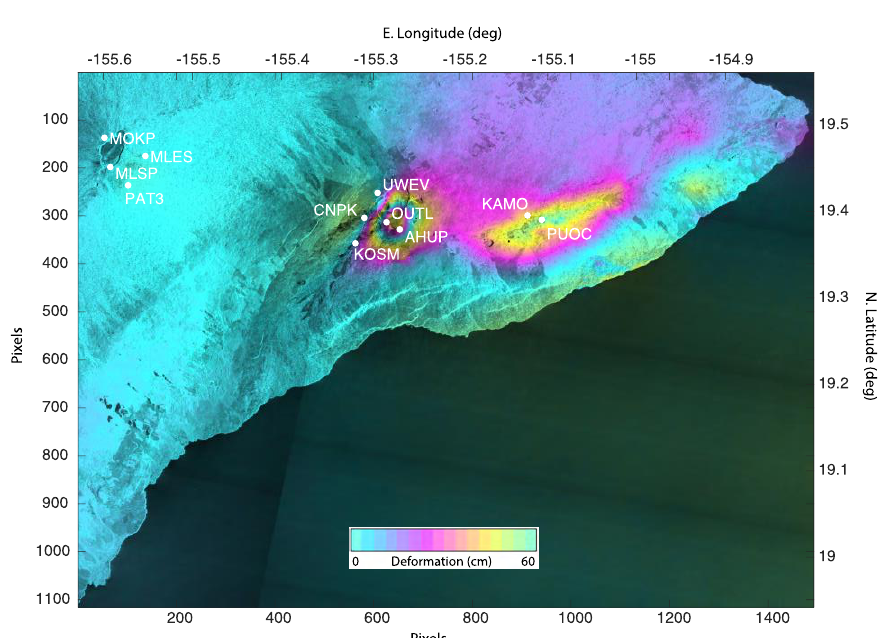
Figure 3. GPS locations on the InSAR cumulative displacement image for part of Hawaii during 2018. Areas covered are the summit of Mauna Loa, the Kilauea area, and the Pu’u O’o region. While other GPS sites are maintained, the areas are the most instrumented.